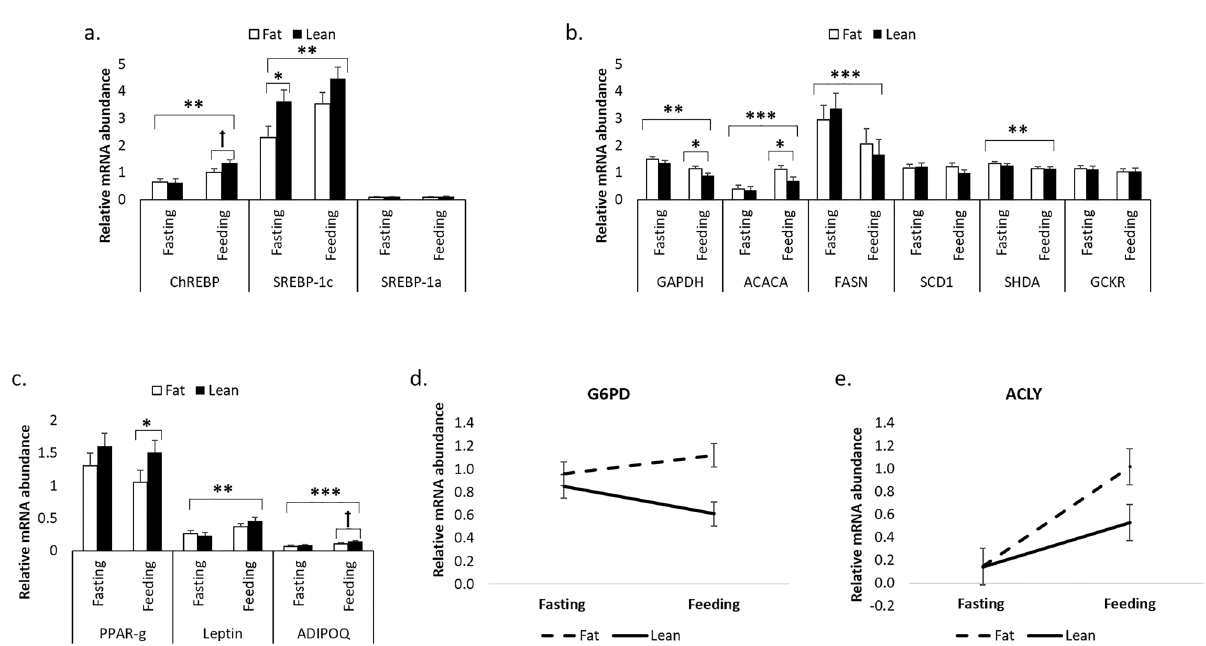
Figure 3. Relative mRNA abundance of transcription factors ( a ), enzymes implicated in lipid metabolism ( b ) and genes associated with insulin sensitivity ( c ) in fat and lean pigs during fasting and feeding (trial 2). Interactions between nutritional state and type of pigs for G6PD and ACLY are illustrated in ( d,e ). Error bars represent SE. *,**,*** and ꝉ stands for P < 0.05, P < 0.01, P < 0.001 and P < 0.10, respectively (n =